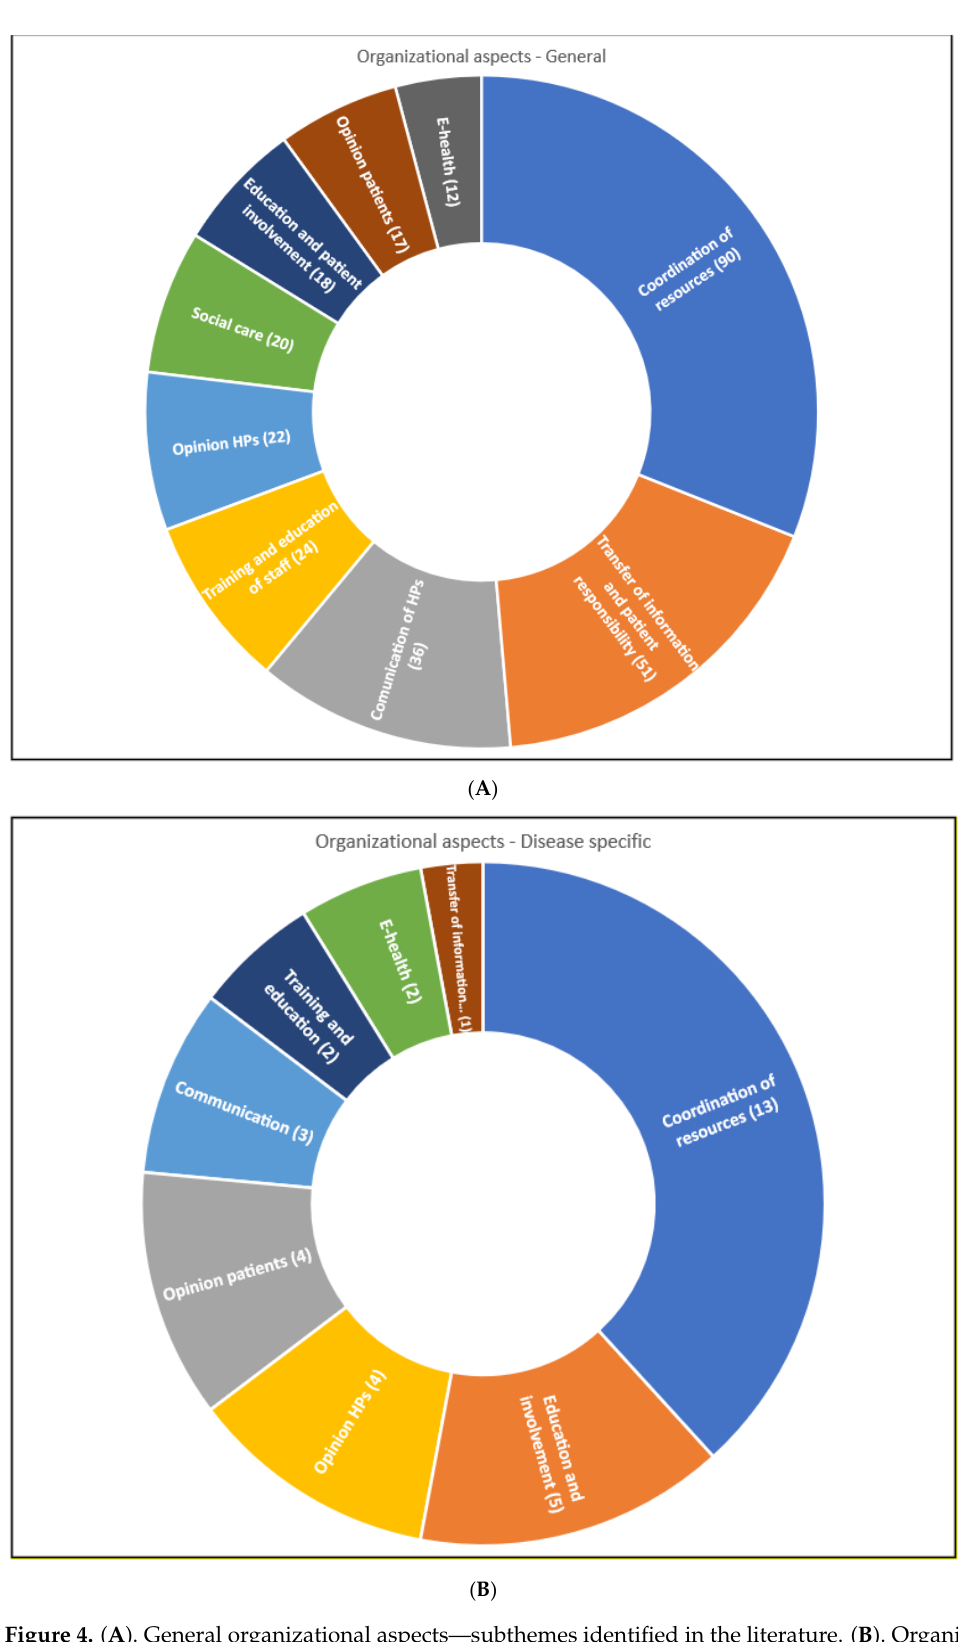
Figure 4. ( A ). General organizational aspects—subthemes identified in the literature. ( B ). Organi- zational aspects in case of a specific disease or condition—subthemes identified in the